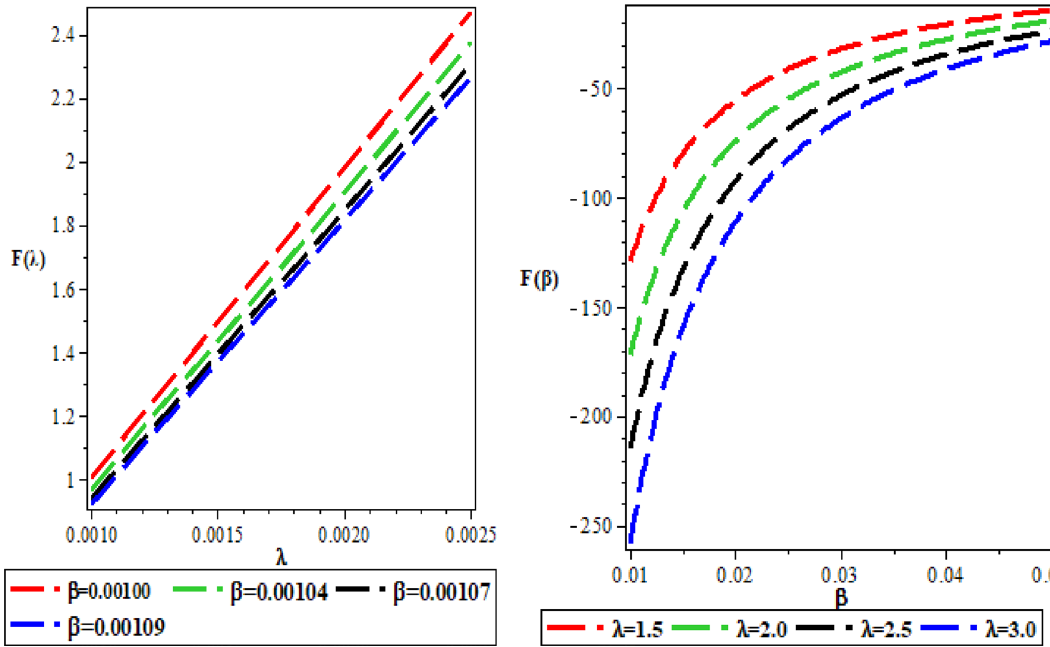
Figure 6. Variation of vibrational free energy against the maximum quantum state (λ) and temperature parameter (β) respectively.